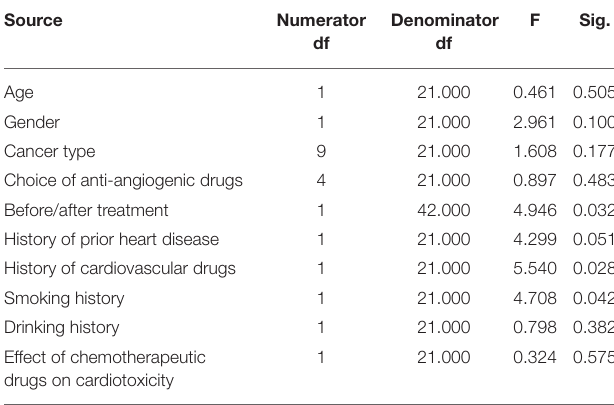
TABLE 5 | Type III test of fixed effects of CK.